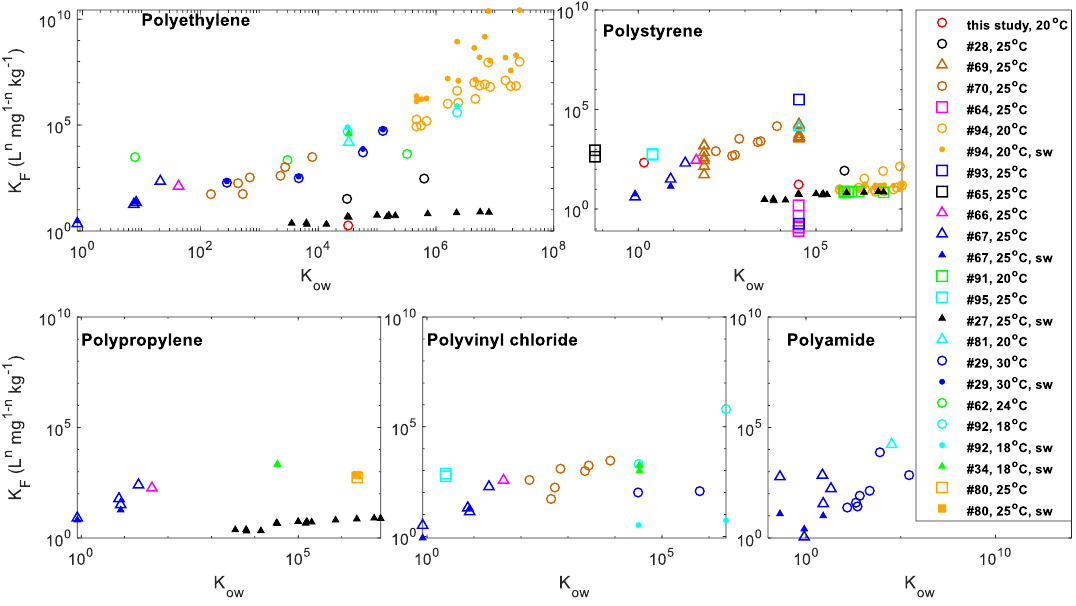
Figure 2. Literature values of K F vs. the K ow of chemicals examined. The K F values were fit to the Freundlich adsorption model and n values were not always assumed to be 1. sw indicates experiments conducted in filtered or synthetic seawater. Our study determined K F of DCF on PE was 1.82 ( n = 1), DCF on PS was 17.13 ( n = 1), and ATN on PS was 215.95 L n mg 1−n kg −1 ( n = 0.97). Li et al. (2022) found higher DCF sorption capacity with increasing PS size [64]. Wang et al. (2019) also explored the size effect on sorption and found some irregularity between the size of the PS and the sorption of phenanthrene and nitrobenzene due to the aggrega- tion of 50-nm PS particles [69]. The low dispersal of these particles and their aggregation then limited the chemicals ’ access to sorption sites. While acknowledging the role that hydrophobicity played in sorption, they also found that other mechanisms such as π - π interaction may be also involved in the sorption of phenanthrene and nitrobenzene on PS. Hüffer and Hofmann (2016) found similar lack of correlation between the size of micro- plastics and sorption [70], and since they found the aromatic phenyl groups had higher sorption onto larger PS particles than smaller PE and PVC particles, they concluded that it was due to strong π - π interactions between PS and aromatic organic compounds [70,90]. In addition, Liu et al. (2016) provided evidence that π - π interaction and the chemical